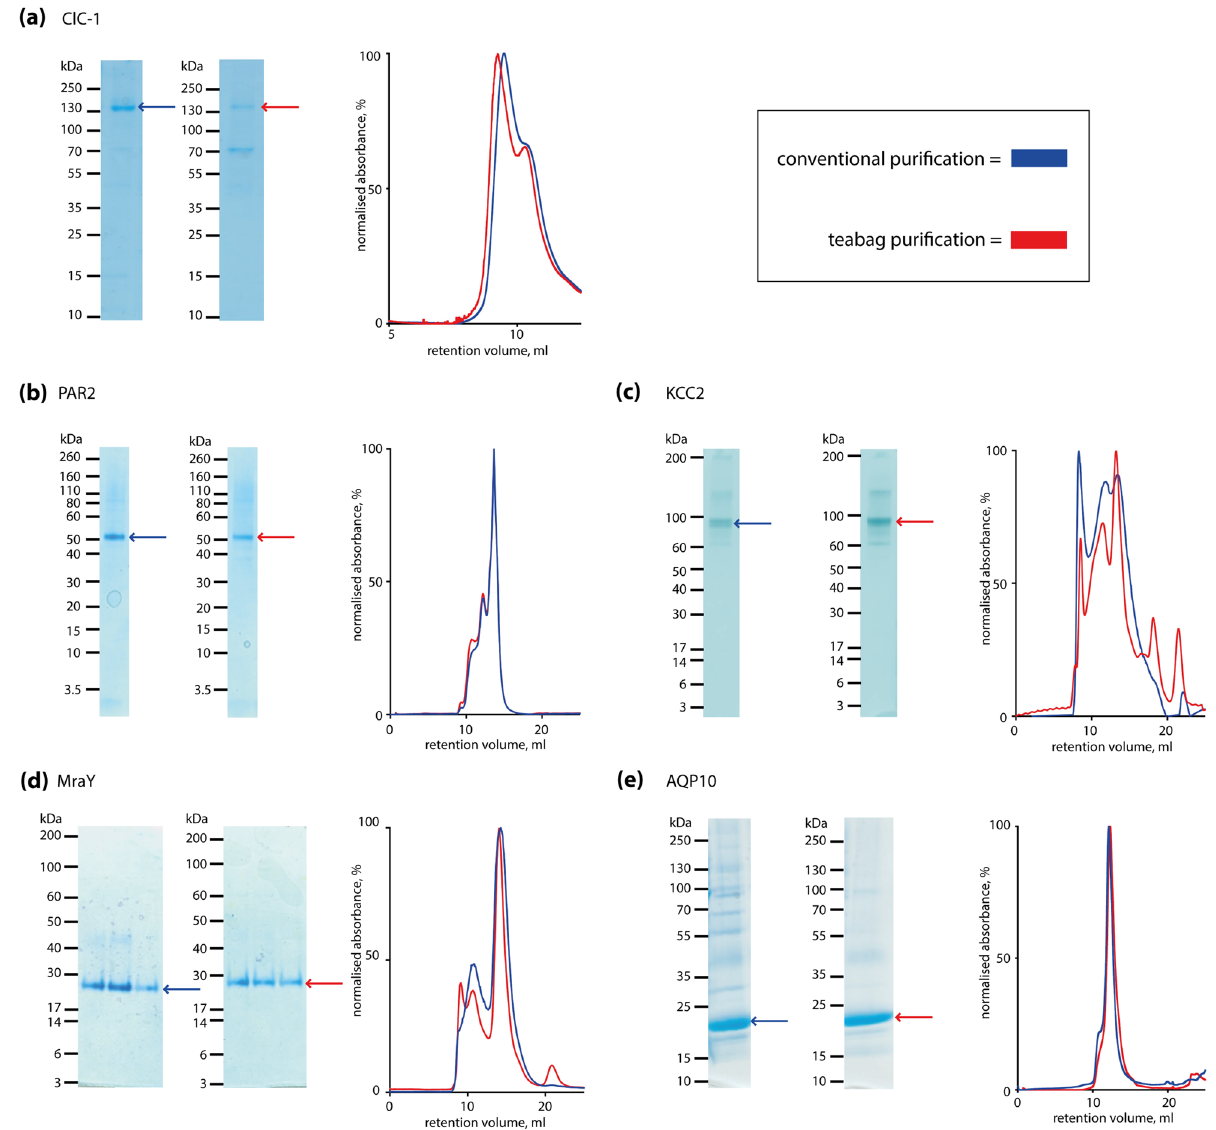
Figure 2. Comparison of conventional and teabag purification of five different membrane proteins. Each panel shows the results from side-by-side comparison of conventional and teabag purifications, respectively. SDS- PAGE with conventional (left) and teabag (right) purification, and SEC profiles with conventional purification (blue) and teabag purification (red). ( a ) Human ClC-1 chloride channel; ( b ) human PAR2; ( c ) Monodelphis domestica KCC2; ( d ) Clostridium bolteae MraY; ( e ) human AQP10. For each pairs of SDS-PAGE images, comparable amounts of protein have been loaded and the brightness and contrast is equal and applied across the entire image, non-cropped SDS-PAGE images are provided in the Supplementary